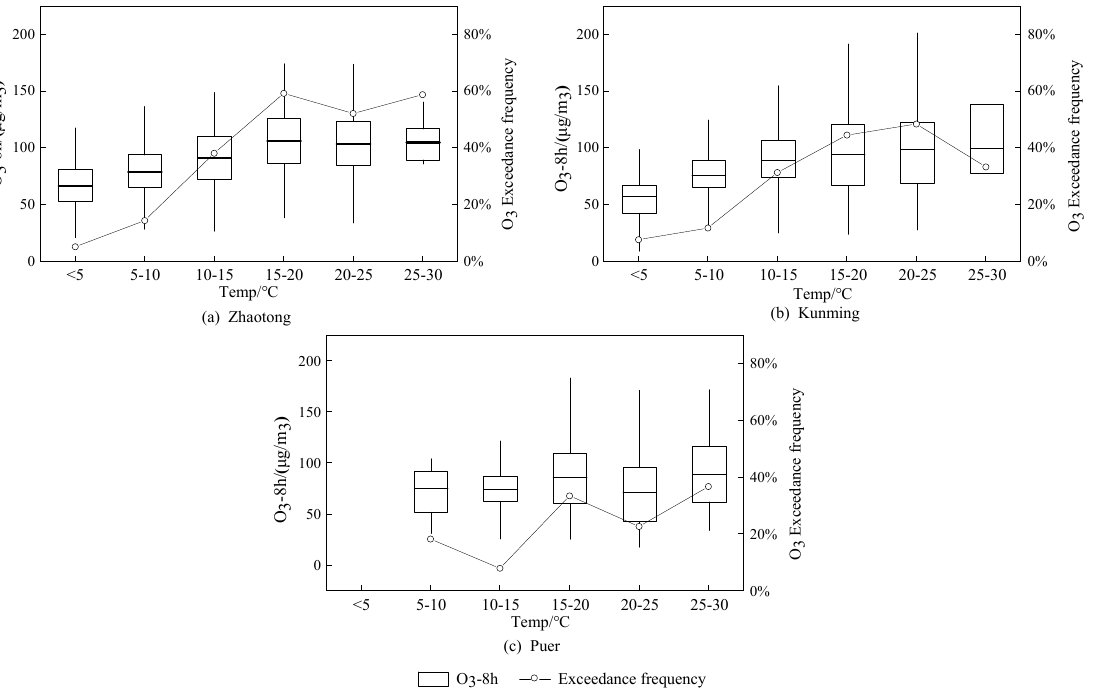
Figure 8. Zhaotong, Kunming and Pu’er at different temperatures. Changes in O 3 concentration and exceeding standard frequency.